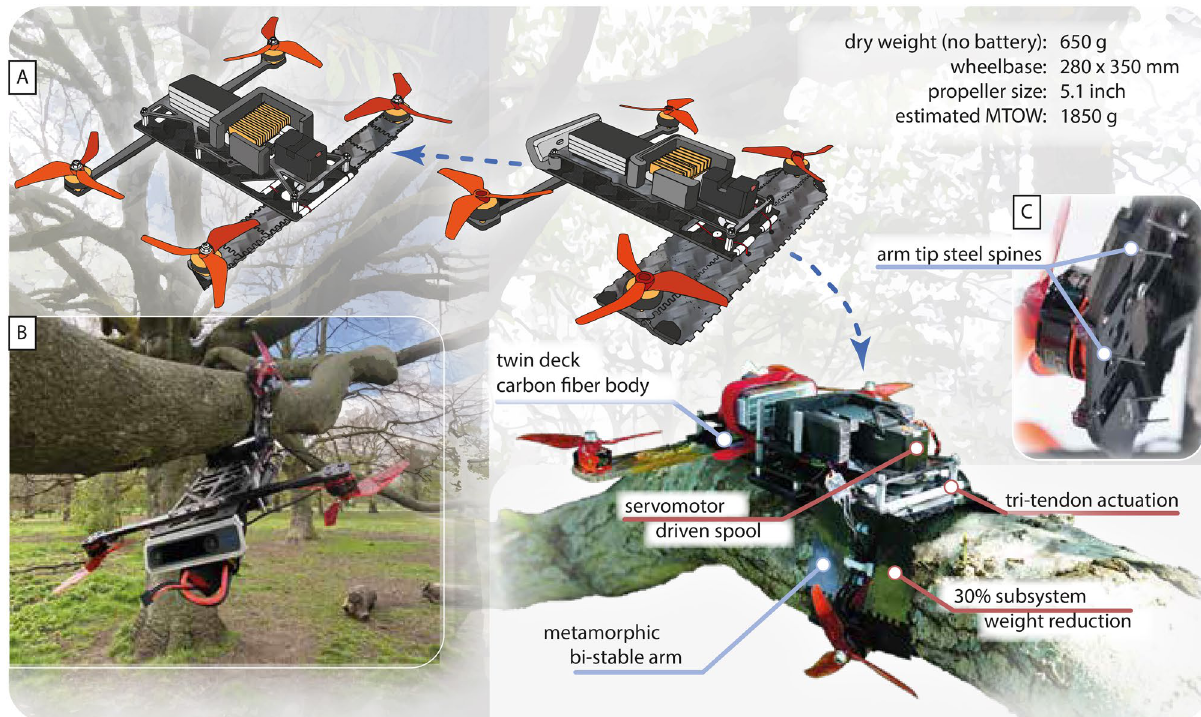
Figure 1. The metamorphic perching quadrotor robot. ( A ) Perching mission cycle with the drawings of the robot in the locked, unlocked, and perched state. ( B ) A photograph of the prototype robot perching upside down on an English oak tree. ( C ) The embedded steel spines across the flat unlocked